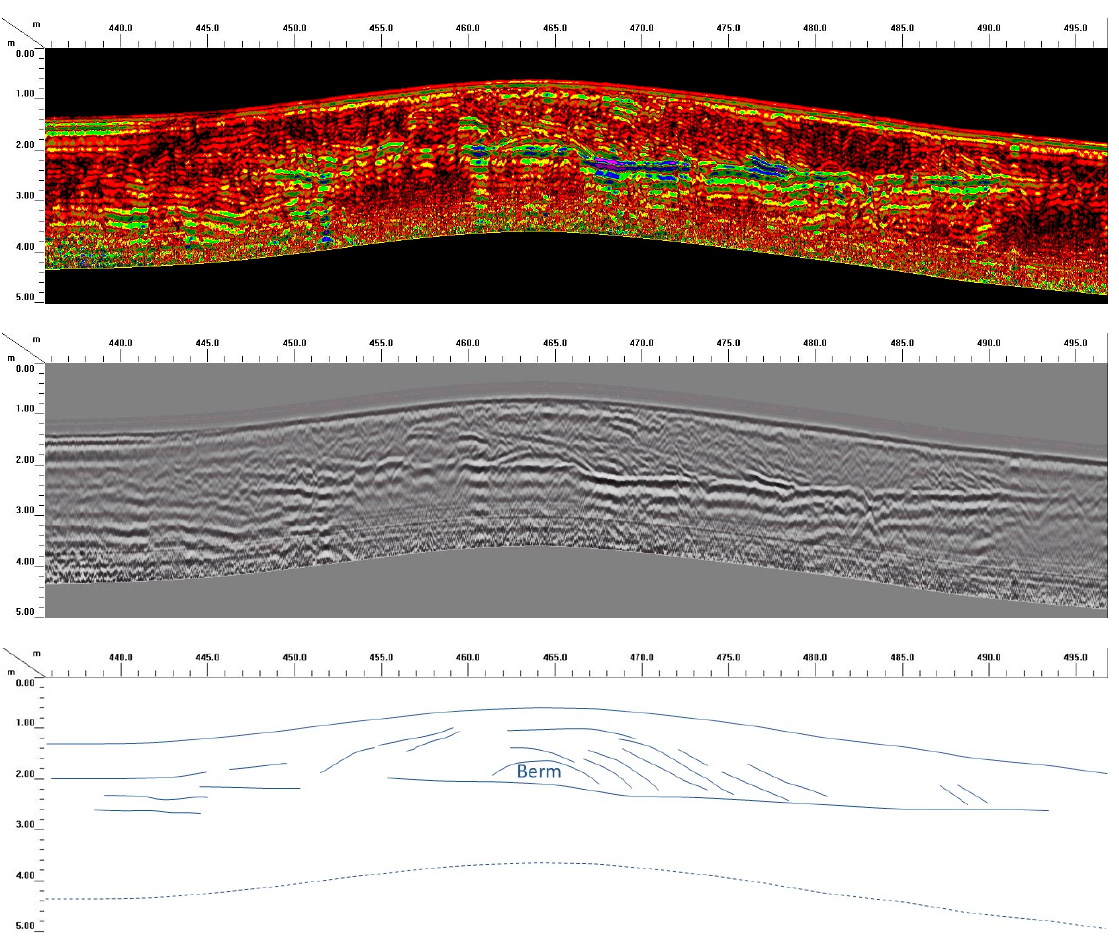
Figure 11. GPR profile and interpretation for the 1720 m shoreline. In the upper transect, data are presented with a color scale to highlight the normalized intensity of radar reflectors. The lower profile presents the same data in grayscale. In both profiles, landward is to the left and lakeward is to the right. Vertical exaggeration 3×.